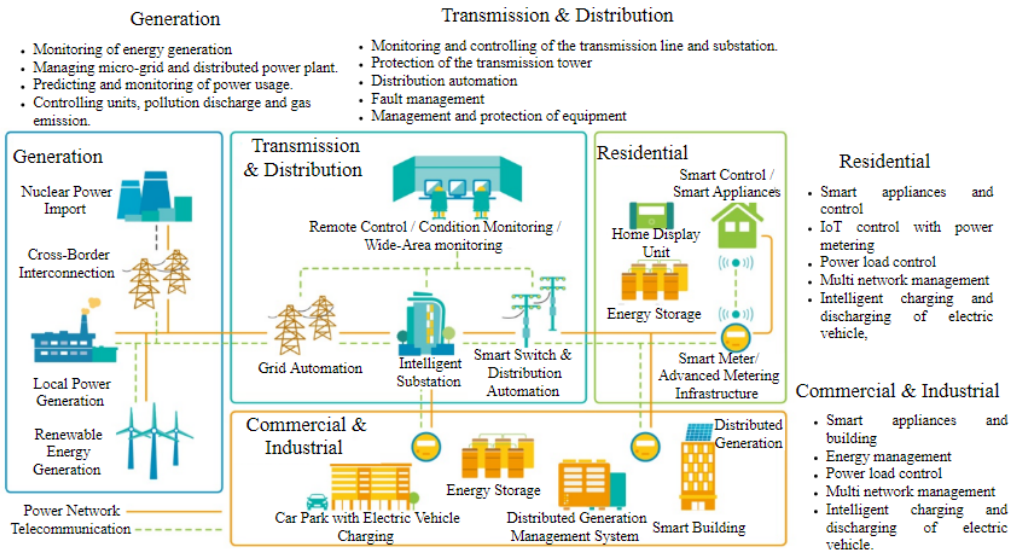
Figure 2. Smart grid services conceptual representation highlights renewable energy resources, energy storage systems, power electronics, information and communication technologies, energy management platforms, and cyber technologies.